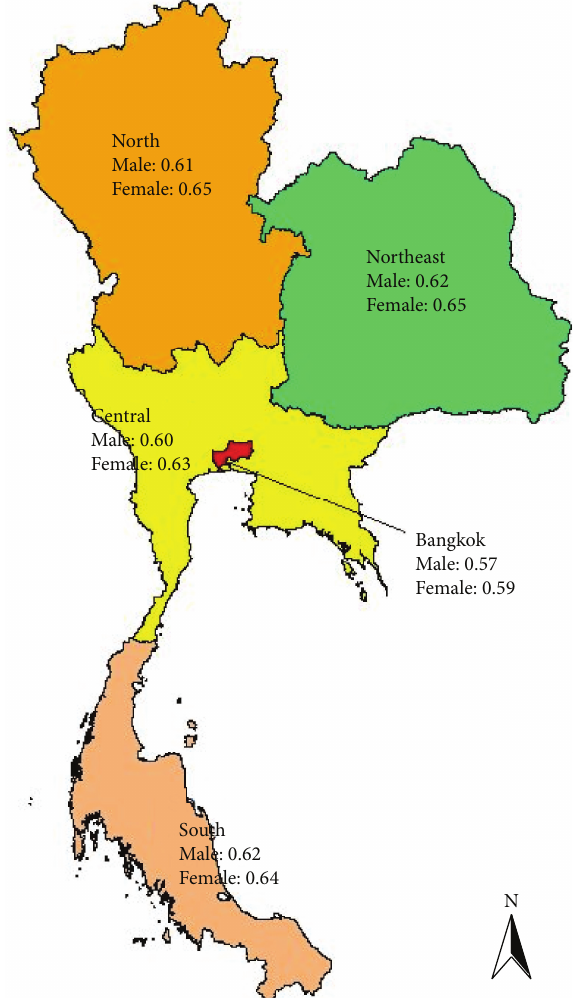
Figure 3: Map of Thailand with region-wise mean active ageing index value of female and male older